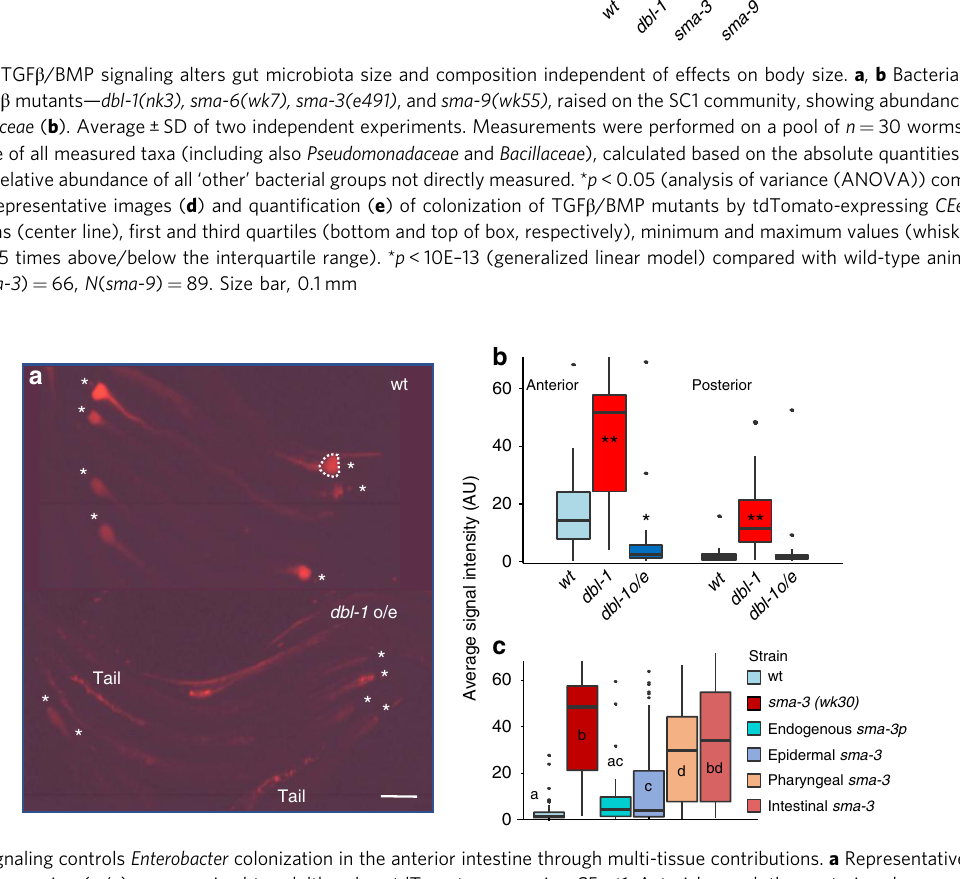
Fig. 5 TGF β /BMP signaling controls Enterobacter colonization in the anterior intestine through multi-tissue contributions. a Representative images of wild- type and dbl-1 overexpressing (o/e) worms raised to adulthood on tdTomato-expressing CEent1 . Asterisks mark the posterior pharynx, size bar, 0.1 mm. b Box plots (described under Fig. 4) quantifying fl uorescent signal (normalized to area) in images as in a , either in the anterior gut (dashed line in a ), or posterior to that. n = 38 (wt), 50 ( dbl-1 ), 28 (dbl-1 o/e); ** p < 0.0001, * p < 0.05, generalized linear model. c Similar quanti fi cation in the anterior gut of wild-type worms, or sma-3 mutants, as well as in sma-3 derivatives with transgenic tissue-speci fi c sma-3 expression. Statistically distinct groups ( p < 0.05) are marked with different letters (analysis of variance (ANOVA) followed by a Tukey ’ s post hoc test; n = 71( wt ), 60 ( sma-3 mutants ), 48 (endogenous sma-3 promoter), 86 (epidermal sma-3 ), 40 (pharyngeal sma-3 ), 33 (intestinal sma-3 ), all